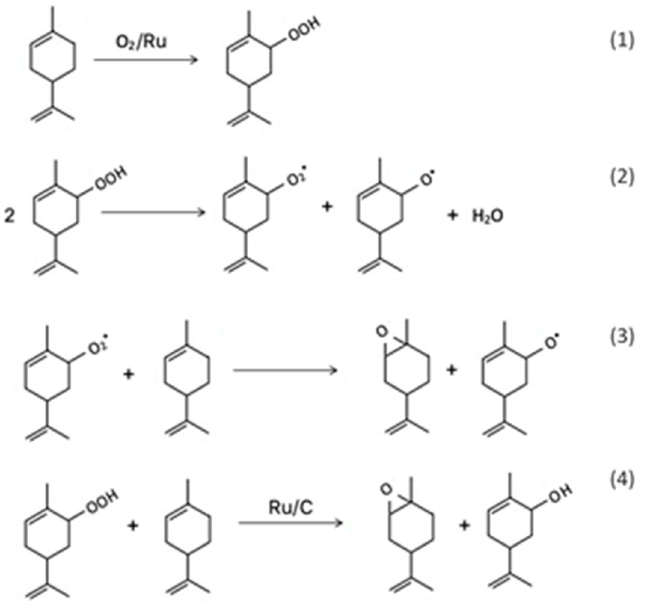
Table 6. Aerobic epoxidation of limonene over supported ruthenium catalysts on activated carbon prepared by different methods